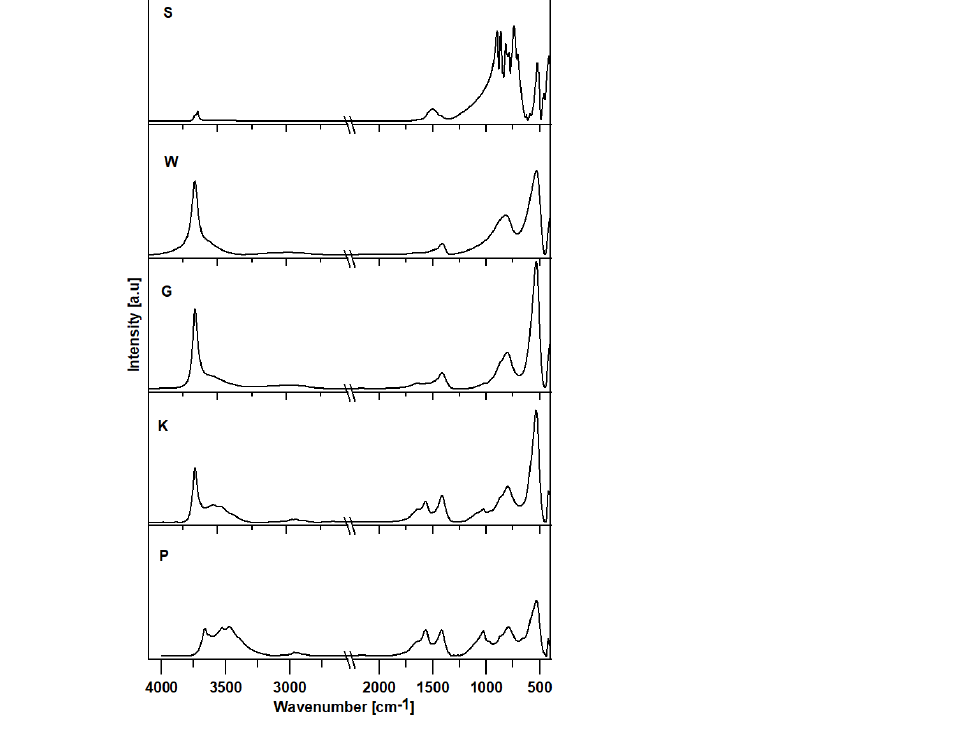
Figure 17. Surface-normalised FTIR spectra of calcium aluminate C 3 A (S — not treated) phase sub- jected to water (W), pig slurry (G), corn silage (K) or chicken manure (P) in the wavenumber range 4000 – 400 cm − 1 .